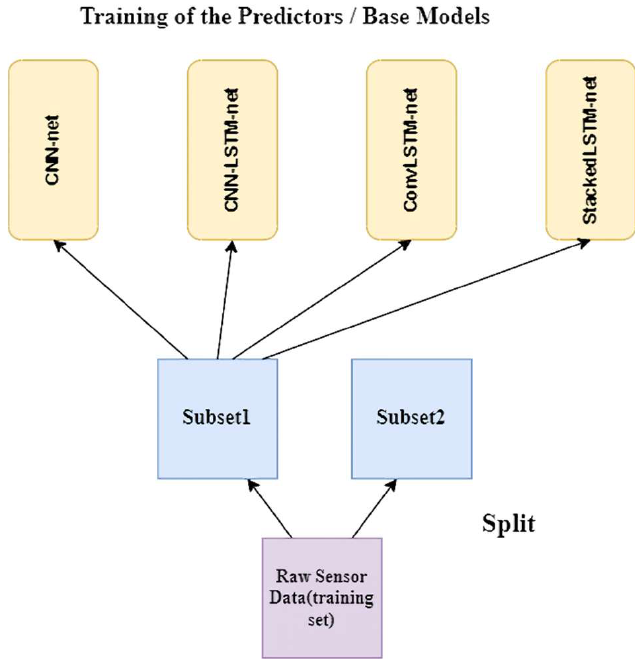
Figure 7. Training the predictors or base models.